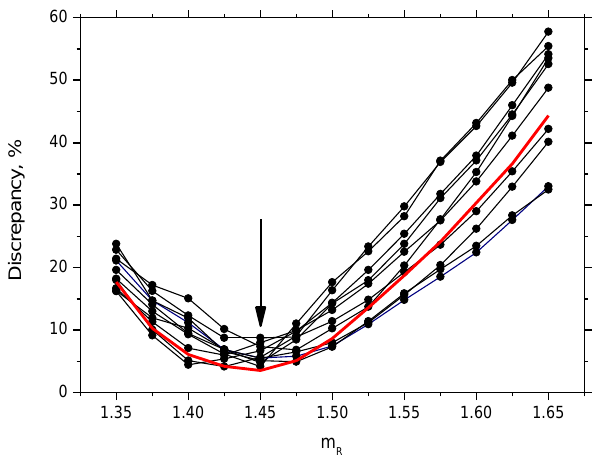
). The simulation was R was 0.01. The I